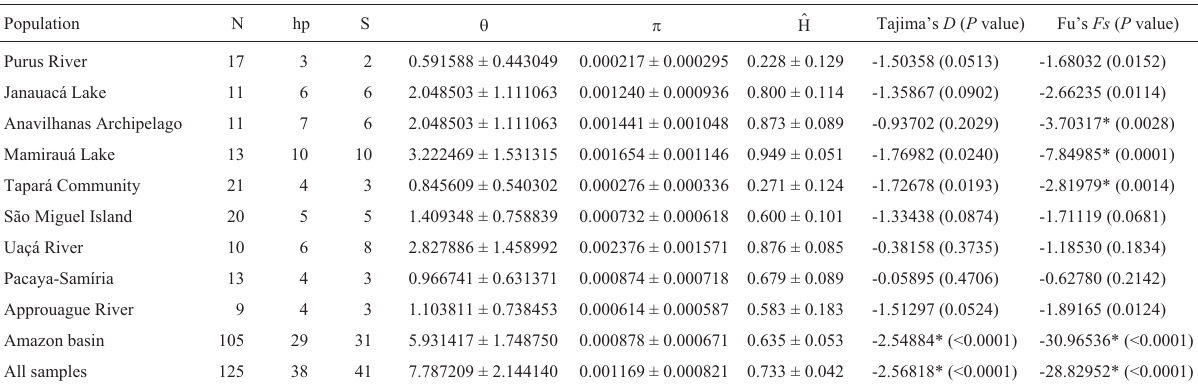
(cid:1) H= Nei’s gene diversity. * Significant